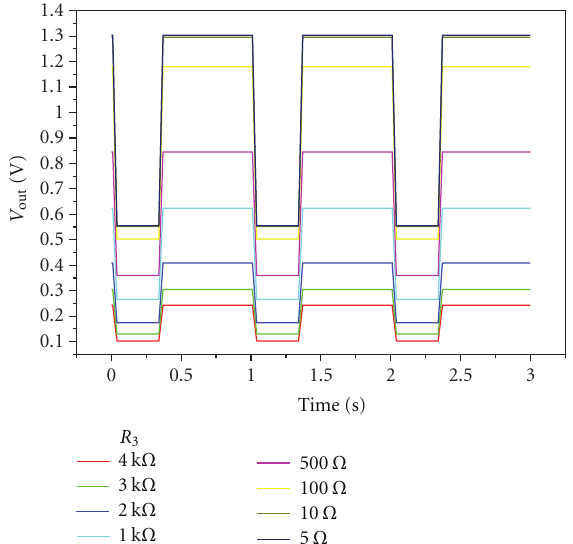
Figure 15: Output voltage levels for the pulse parameter for a change of the resistance of R 3 (5 ( Ω ) ∼ 4 (k Ω )).